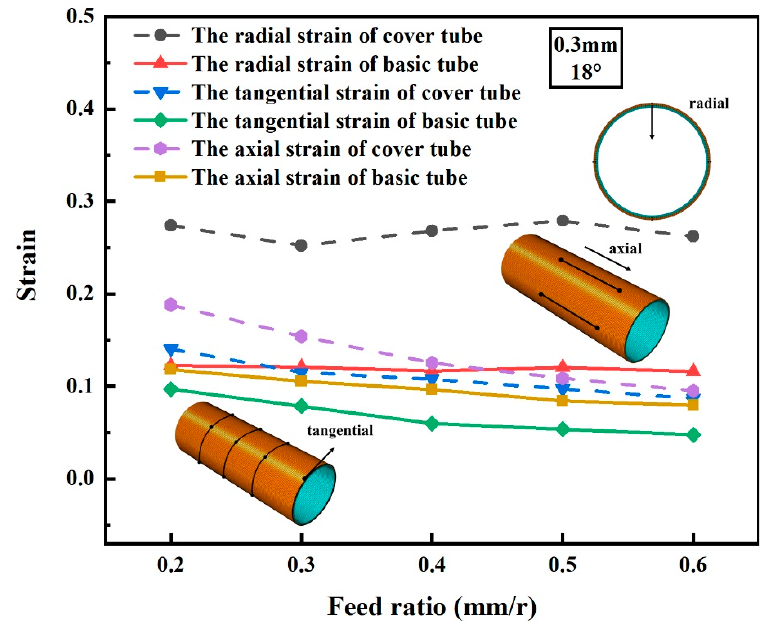
Figure 10. Three-way strain distribution for basic and cover tubes with different feed ratios.